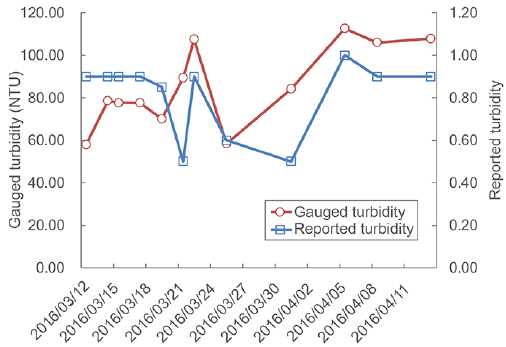
Figure 8. The water turbidity from the reports and gauged